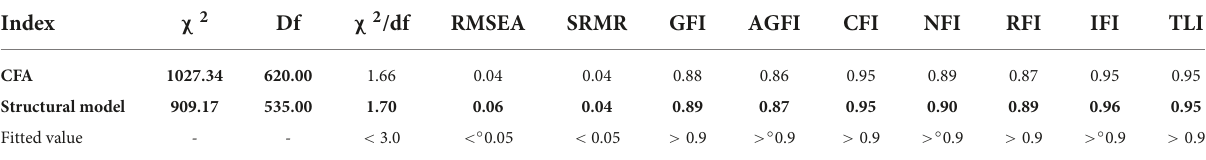
TABLE 4 The result of model